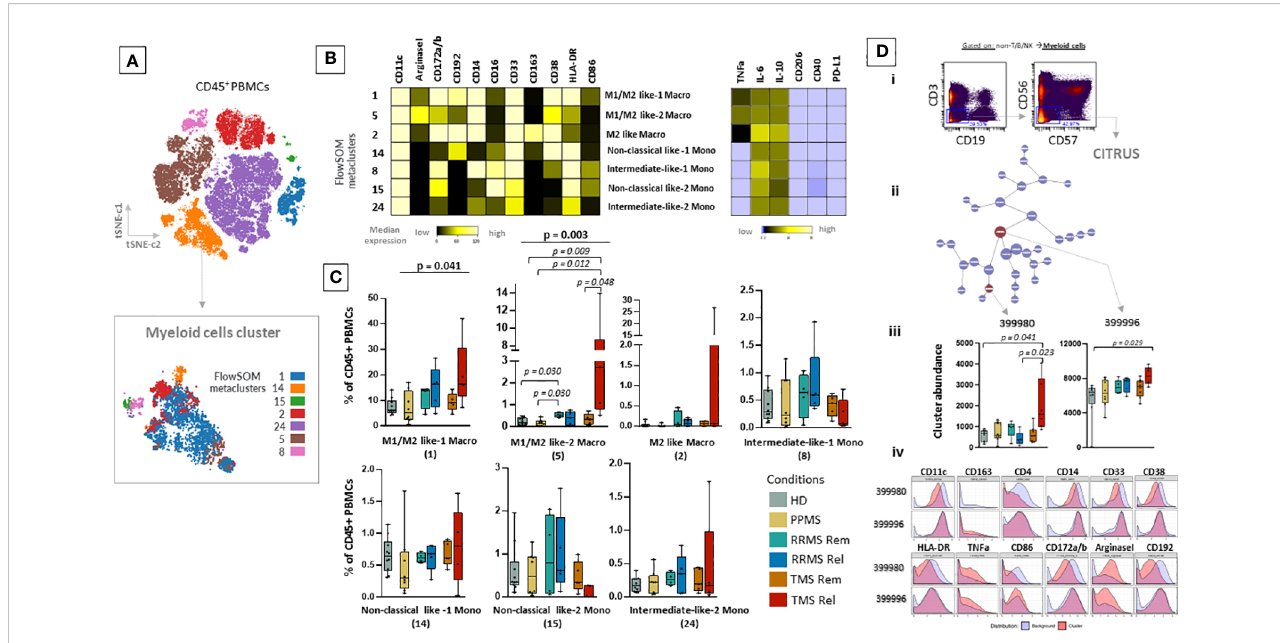
FIGURE 3 Expansion of a myeloid speci fi c signature in TMS patients during relapse. (A) FlowSOM resulted metaclusters in myeloid cells projected on the tSNE map (a representative example from one healthy donor is shown here). (B) Heatmap for key markers to identify to characterize metaclusters. A